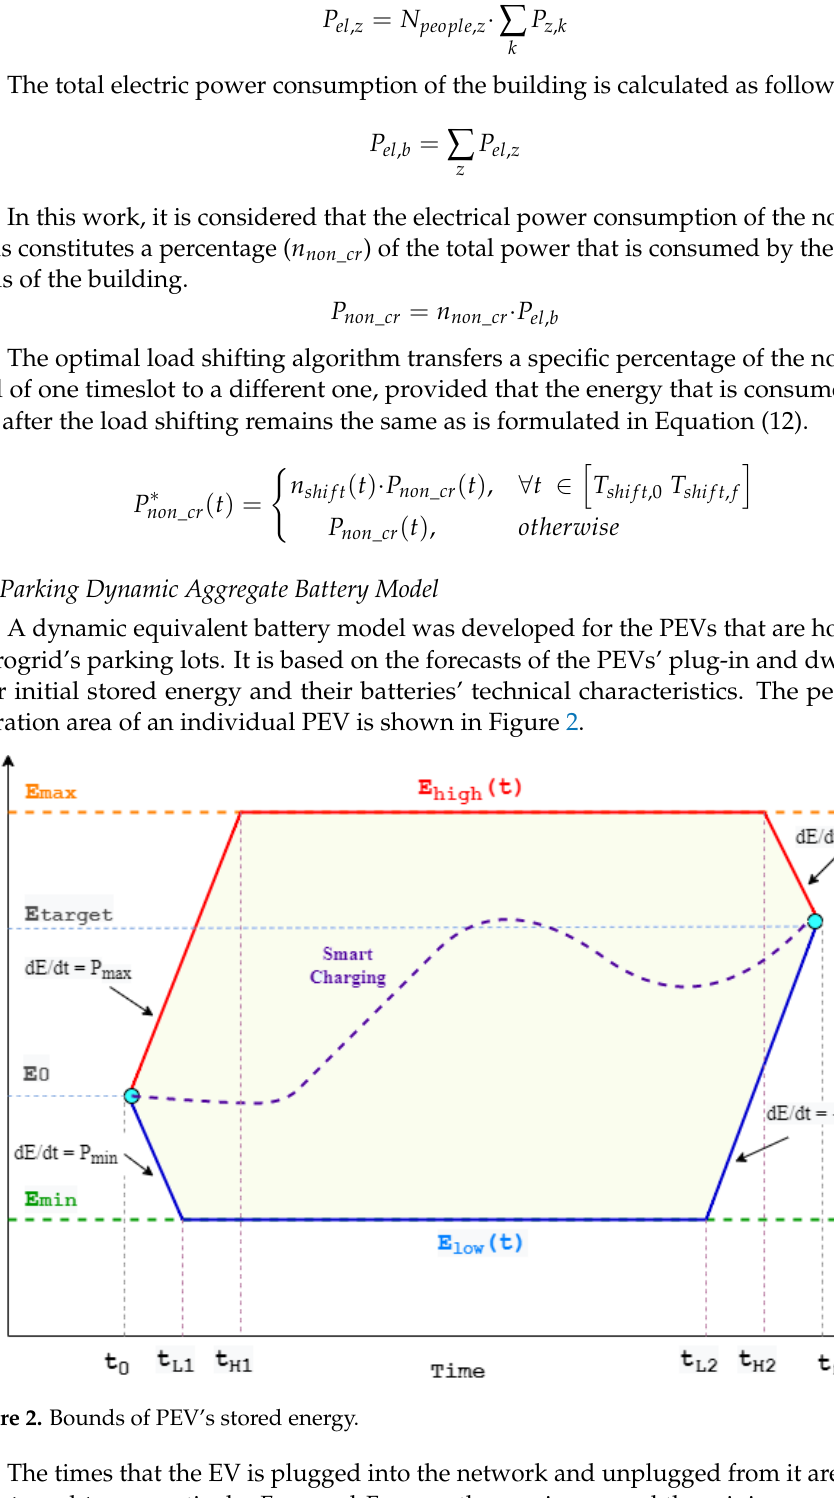
(18) The main goal of the PEV aggregation model is to obtain the dynamic upper and lower limits of the total amount of stored energy in their battery packs and the total active